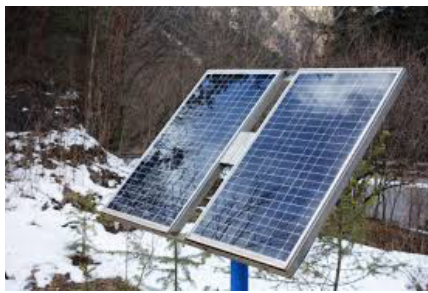
Fig. 1: General View of a photovoltaic module